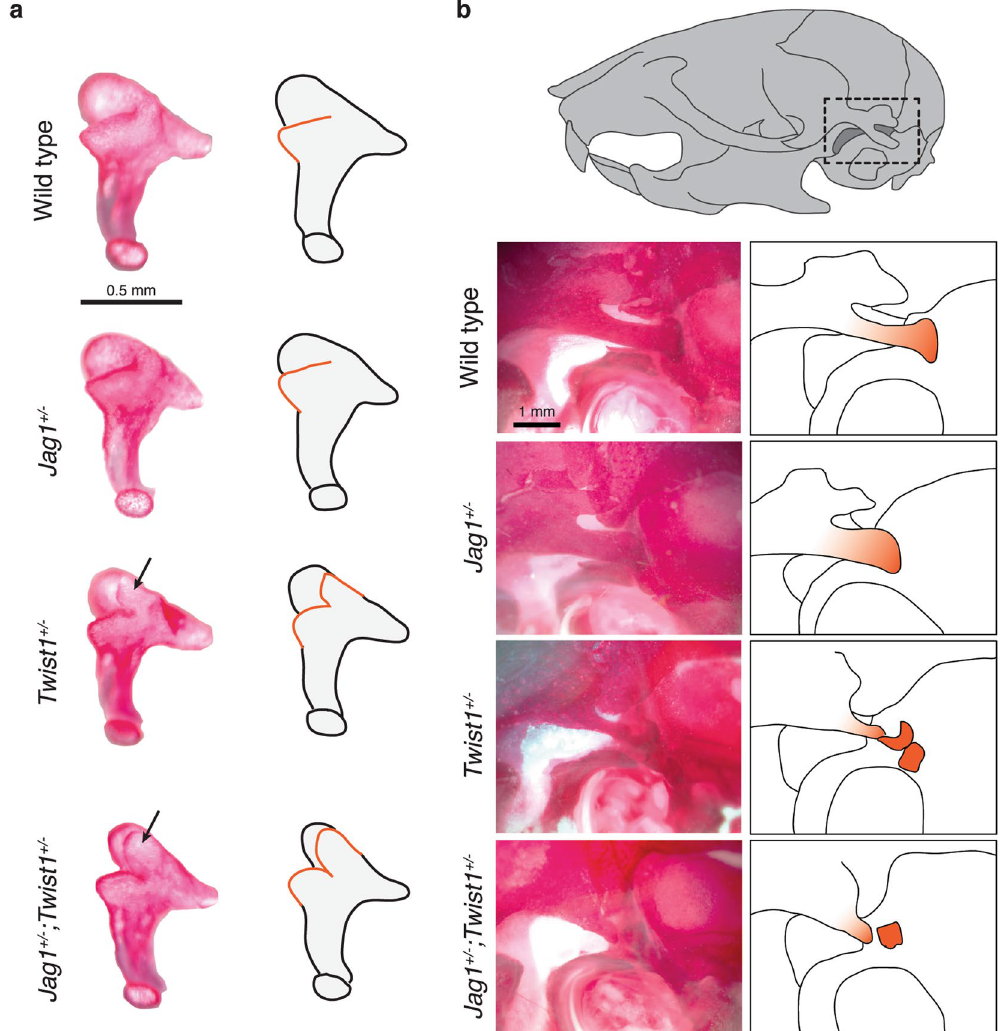
Figure 3. Incus and retrotympanic defects in Jag1 ; Twist1 compound mutants. ( a ) Dissected incus bones of three-week-old mice stained with Alizarin Red S. Wild types and this Jag1 + / − example display a normal incus. In contrast, Twist1 + / − and Jag1 + / − ; Twist1 + / − mice have an extra process (black arrows) extending from the anterior medial edge of the incus body. Accompanying diagrams illustrate the ectopic processes with orange lines. ( b ) Views of the temporal bone in three-week-old mice stained with Alizarin Red S. The dashed box in the illustration shows the approximate region being imaged. Compared to wild-type and Jag1 + / − mice, Twist1 + / − and Jag1 + / − ; Twist1 + / − mice display reduction and fragmentation of the retrotympanic process (shown in orange in the adjacent